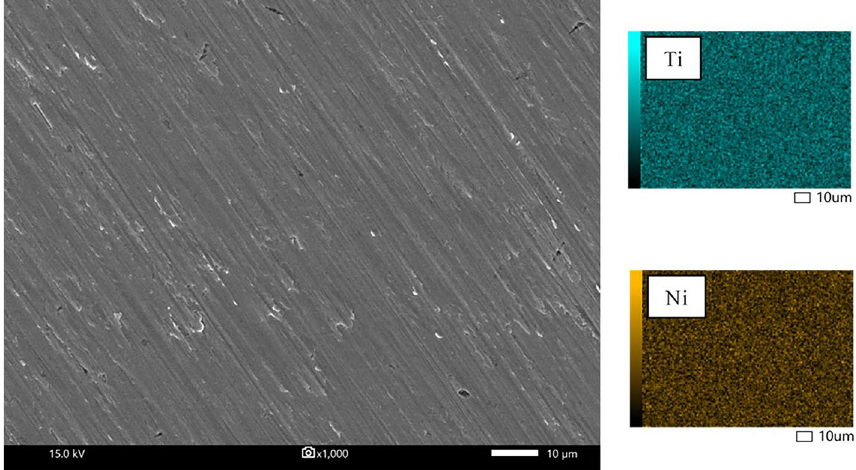
Figure 2. SEM images and EDS mapping of the uncoated NiTi alloy sample.